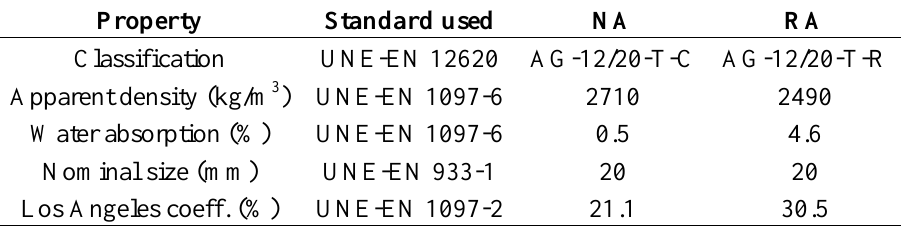
Table 2. Main properties of natural and recycled aggregate.